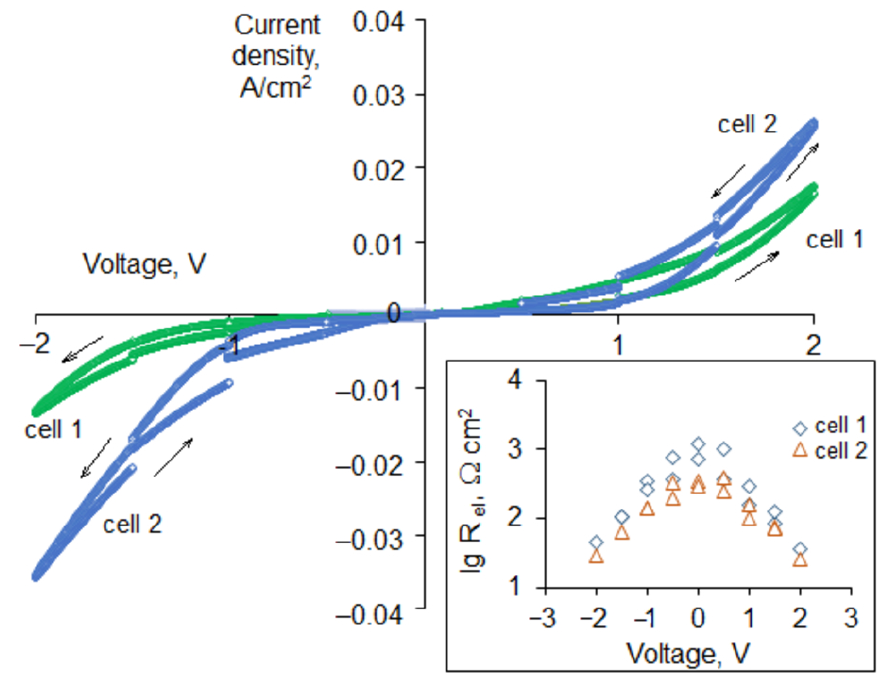
Figure 5. Cyclic voltammetry curves of cells 1 and 2 at 600 °C. In the insert: electrode polarization resistance as a function of applied DC voltage.